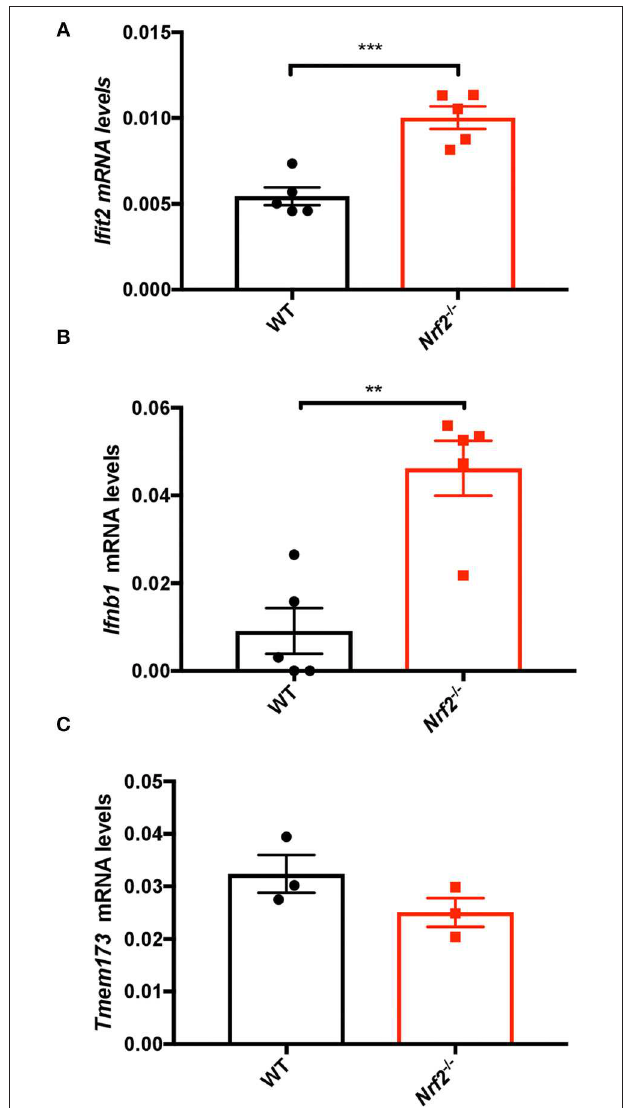
FIGURE 2 | Nrf2 suppresses basal type I IFN and ISG levels in splenic tissues. Spleens from WT and Nrf2 knockout (KO) mice were harvested and RNA isolated. The basal levels of Ifit2 ( Isg54 ) (A) , Ifn β 1 (B) , and Tmem173 (C) were quantified by qPCR, and normalized to Actin . The data are the mean ± SEM where each data point represents one